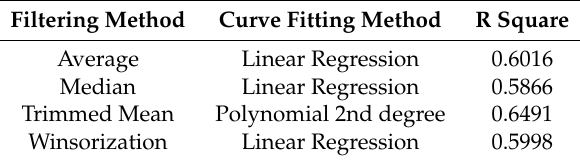
Table 2. RSSI to distance office band 3.